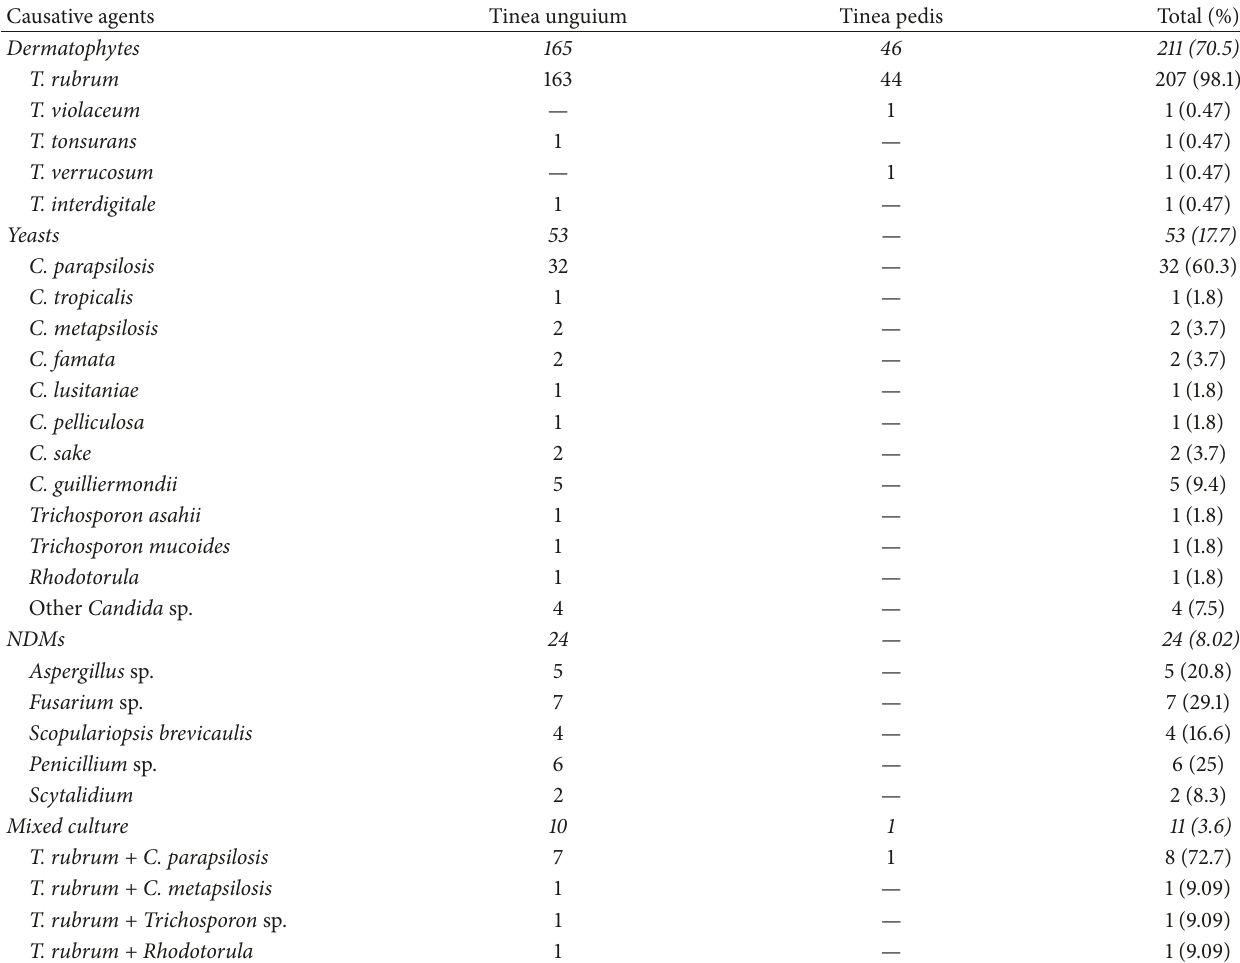
Table 4: Etiological agents responsible for foot mycoses.